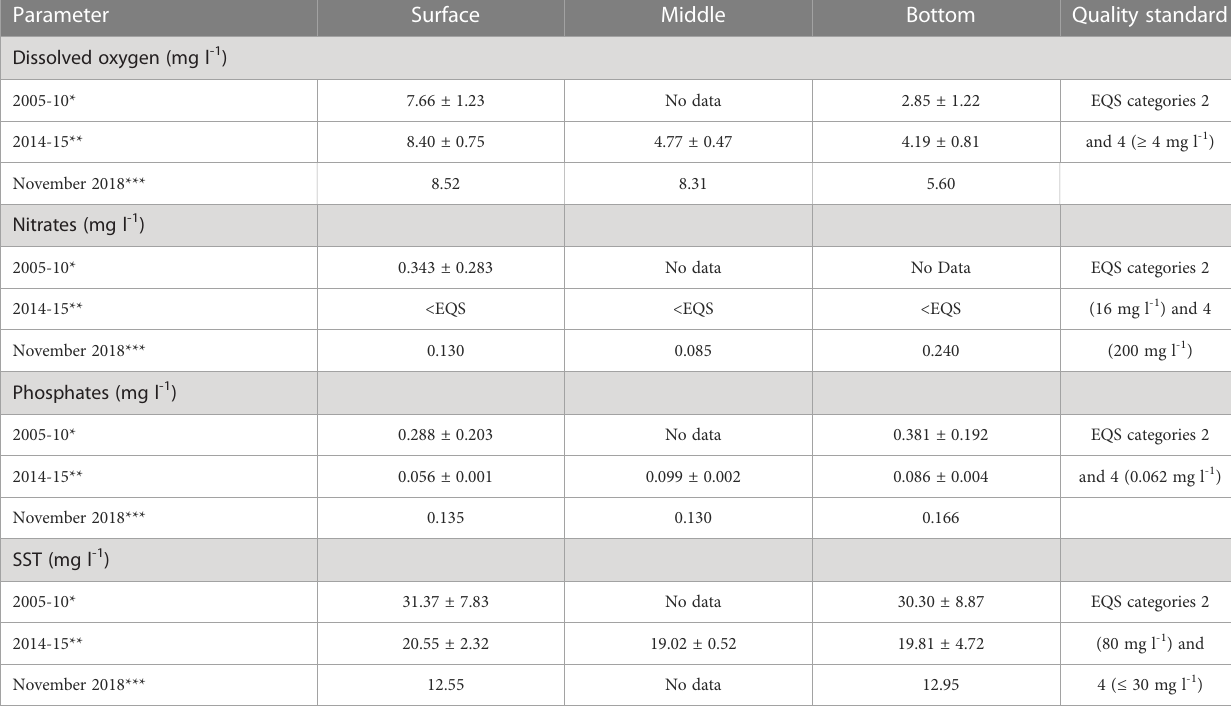
TABLE 1 Physico-chemical parameters of water in Samanco Bay during the period 2005-10, 2014-15, and November 2018. Parameter